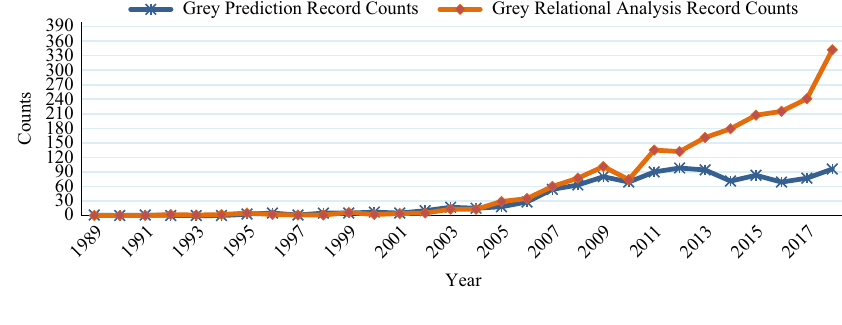
Figure 3. The statistics of publication year of English literature on grey